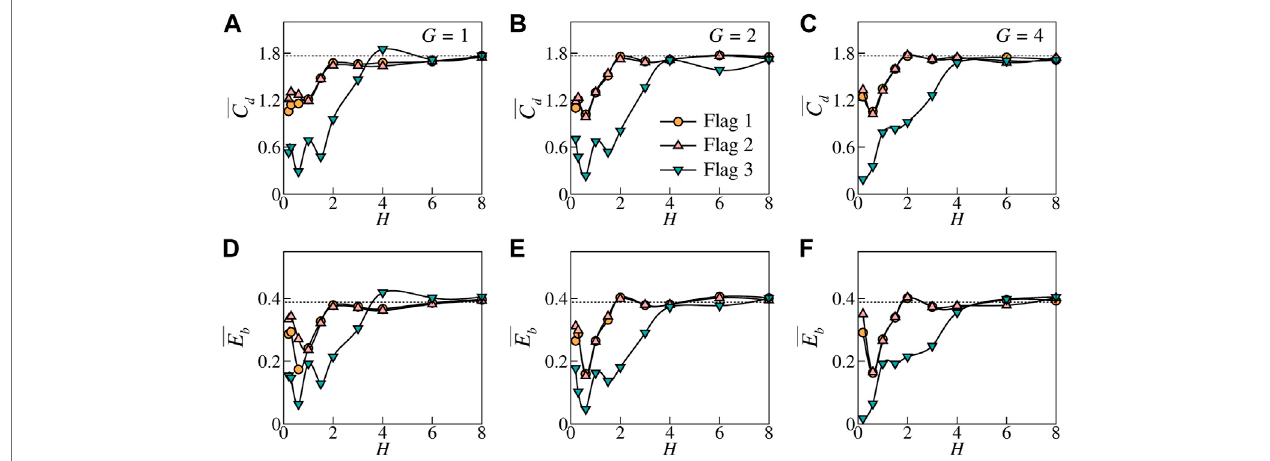
FIGURE 12| The mean drag coef fi cient C d (A,B,C) and bending energy E b (D,E,F) as a function of H for distinct G =1 (A,D) , 2 (B,E) and 4 (C,F) , respectively. The horizontal dash lines represent the corresponding values for an isolated fl ag.